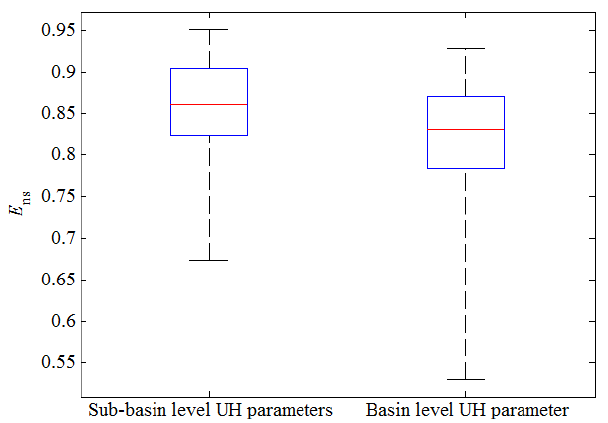
Figure 10. Box plots of ENS values for the SWAT-EVENT model results for sub-basin level UH parameters and basin level UH pa-